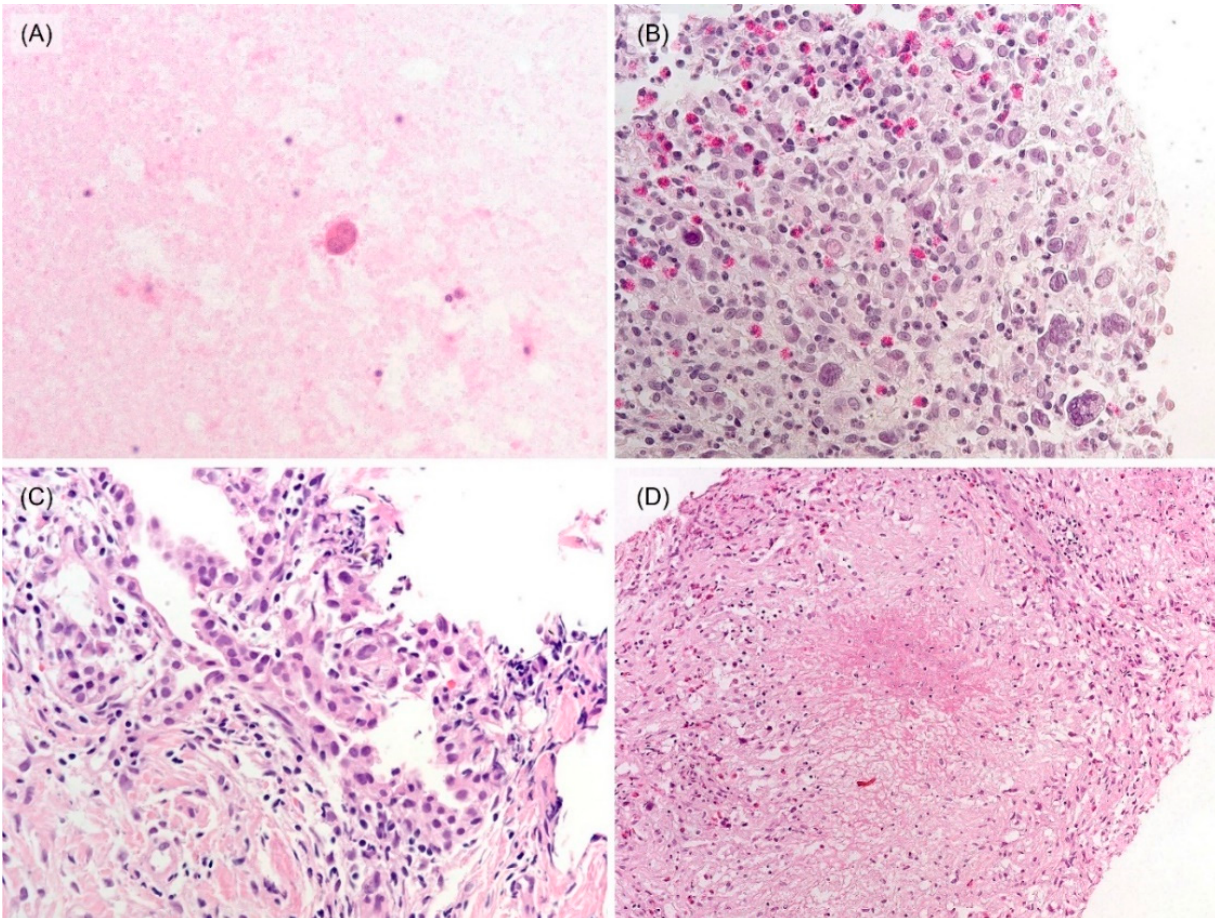
Figure 2. Histologic features of the biopsy specimen. ( A ) Aspiration cytology (case 2): a single RS cell is identified in the bloody background (400 × ). ( B ) Needle biopsy (case 5): a few RS cells are admixed with inflammatory cells, including eosinophils and histiocytes (400 × ). ( C ) Needle biopsy (case 4): activated pneumocytes in PPHL can mimic lung adenocarcinoma (400 × ). ( D ) Needle biopsy (case 6): histiocytic aggregates and necrosis, mimicking tuberculosis (200 × ).